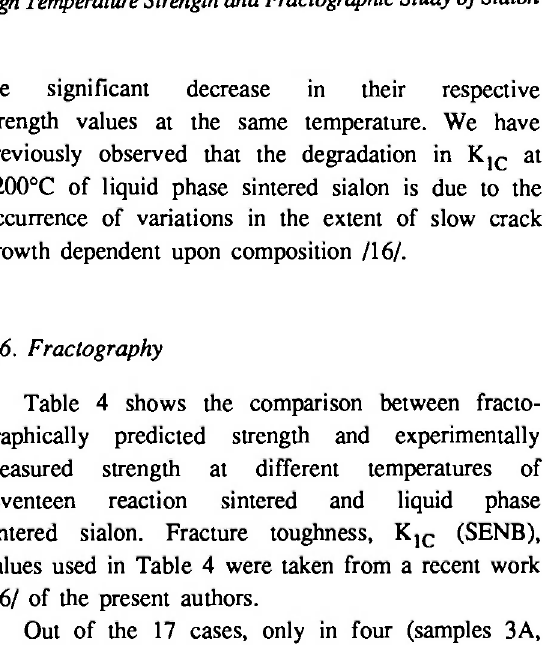
Fig. 11 Dependence of strength on fracture toughness of reaction sintered and liquid phase sintered sialon